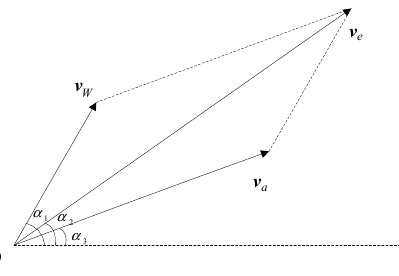
Figure 2. Wind speed synthetic relationship